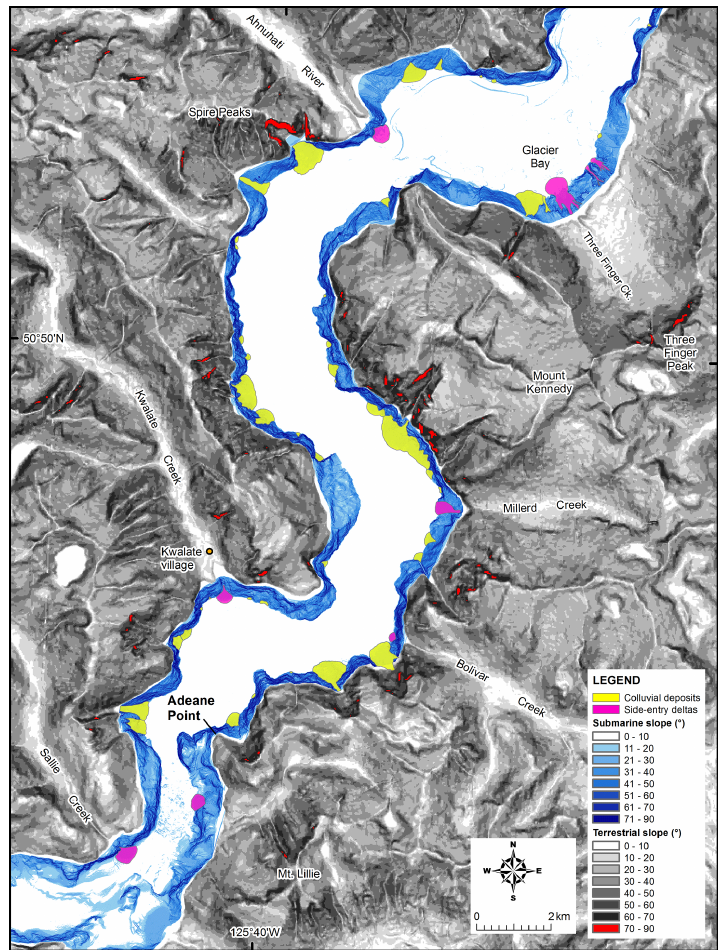
Figure 2. Terrestrial and submarine topography of the middle part of Knight Inlet, showing many colluvial deposits beneath steep rock slopes and side-entry deltas at the mouths of tributary streams. Many of the seafloor deposits mapped in this figure are hybrid colluvial–alluvial landforms; the alluvial deposit beneath Three Finger Creek, for example, contains material from a rock slope failure at Three Finger Peak that produced a wave in November 1999 that was observed 20km to the north at the head of Knight Inlet. SONAR data used to generate DEM were provided by the Canadian Hydrographic Service